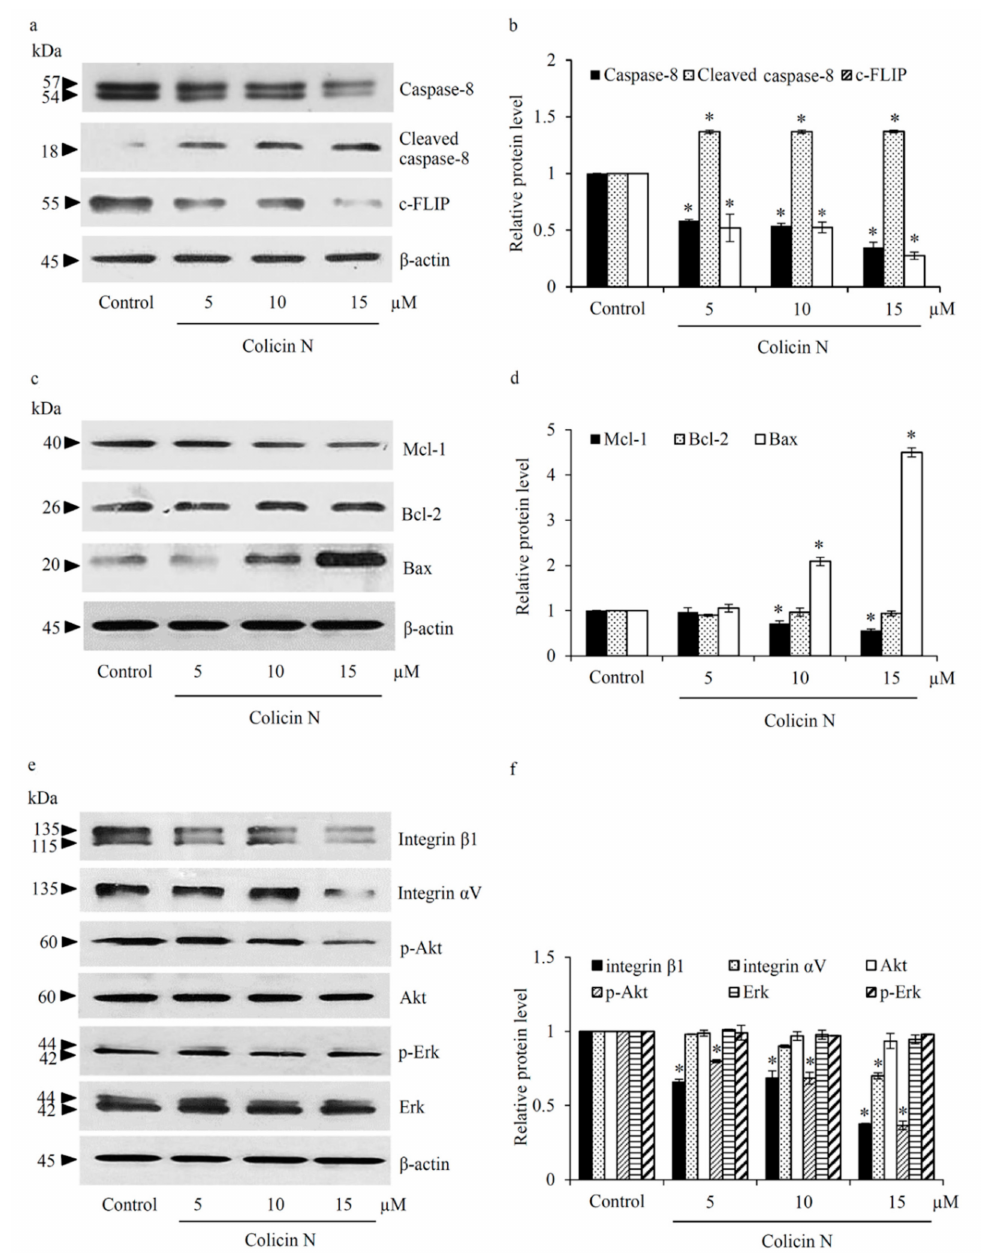
Figure 4. Colicin N suppresses integrin mediated-survival pathways. ( a ) Western blot analysis